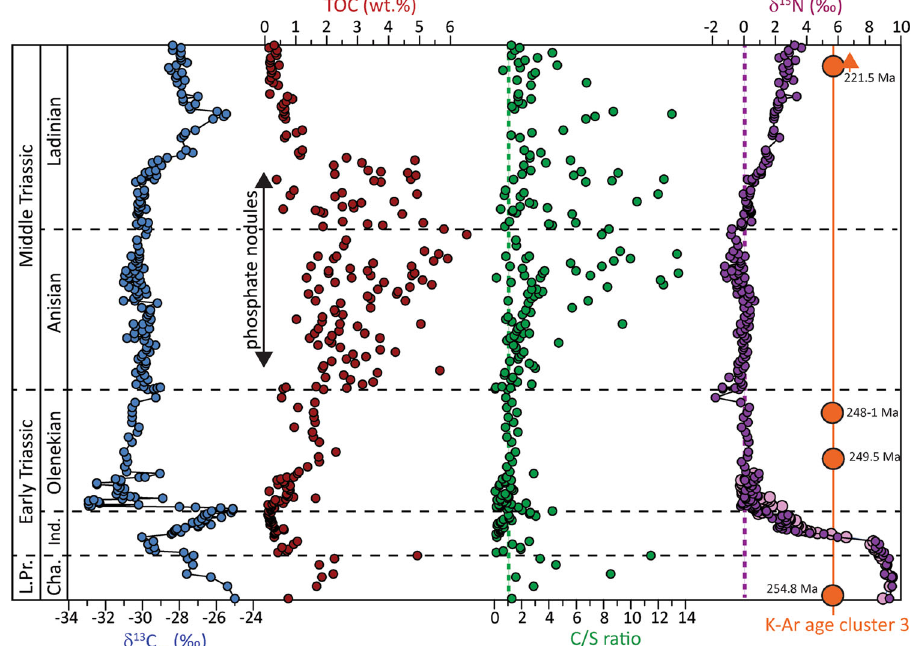
Fig. 8 Geochemical data from Otto Creek, Sverdrup Basin, Arctic Canada. Geochemical pro fi les show variations in carbon isotopes ( δ 13 C org ), total organic carbon (TOC), carbon/sulfur (C/S) ratio, and nitrogen isotopes ( δ 15 N), and are placed in relative time sequence. K-Ar ages of cluster 3 (see Fig. 7) across the LPE and the Late Triassic (221.3 Ma) are shown. The stippled vertical green line indicates C/S ratio ~1 used to de fi ne relative changes in the redox state of the Sverdrup Basin. Prevalence of phosphate nodules are indicated 5 . Stratigraphic sub-units are marked by stippled lines. L.Pr. late Permian, Cha. Changhsingian, Ind.